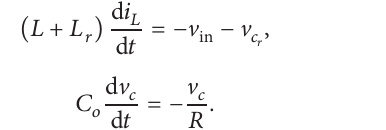
Figure 6: The topology of bridgeless Bipolar-Gain Pseudo-Boost PFC